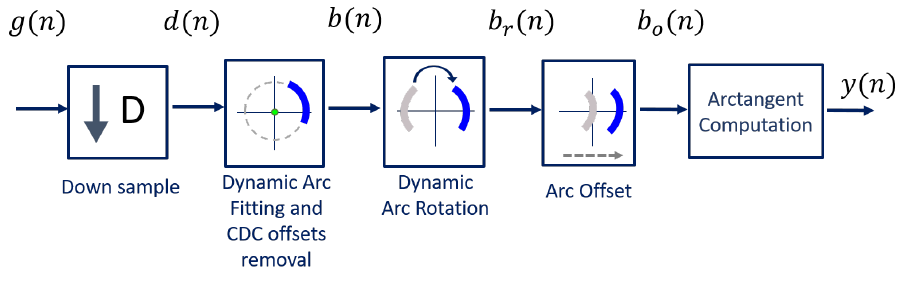
Figure 6. DSP algorithm for extraction of vital